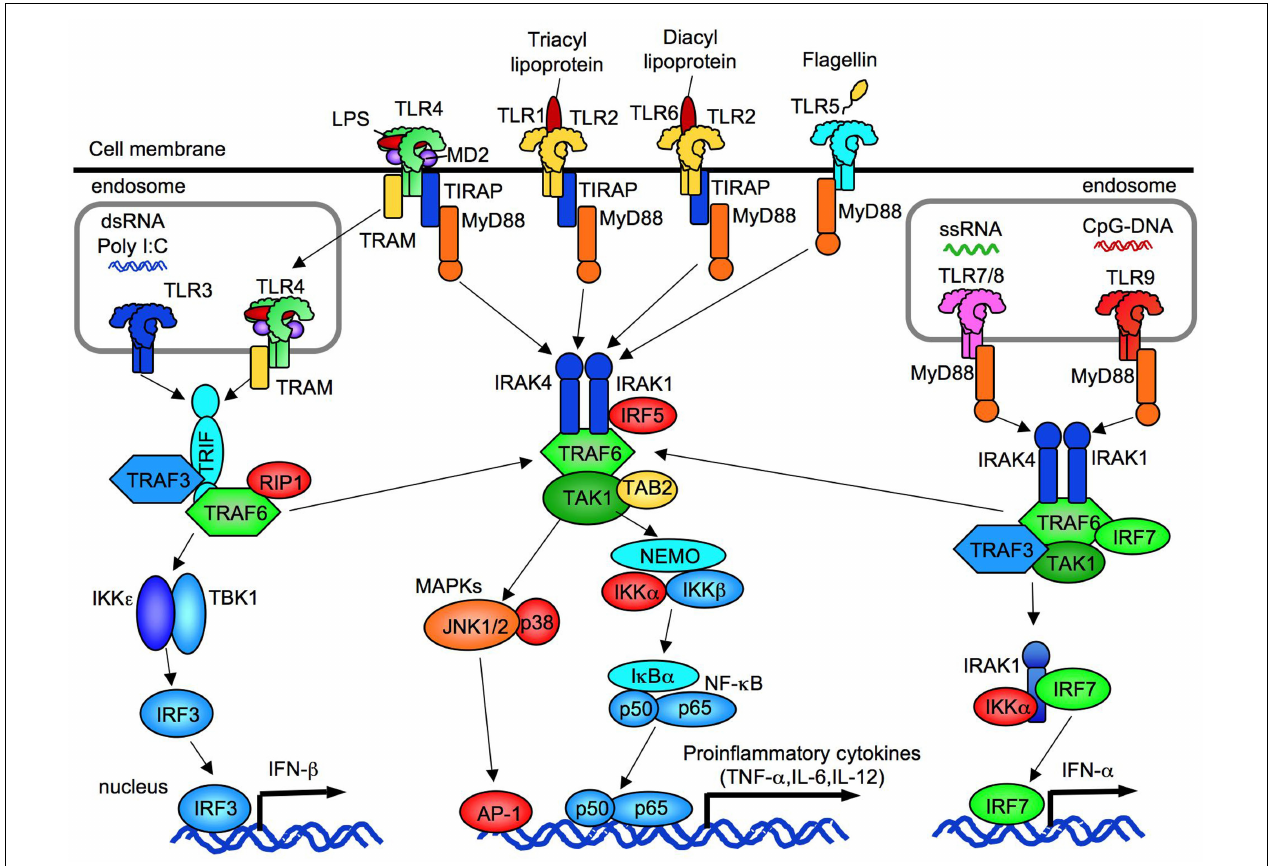
TIRAP and MyD88.TLR3 requires IRIF to activateTBK1/IKK ε . Subsequent to TLR4 internalization,TLR4 signaling activatesTRAM/TRIF-dependent pathway. TLR3/4-dependentTRIF-dependent signaling induces IRF3 activation and IFN- β production.TLR7/8 andTLR9 induce IFN- α production through